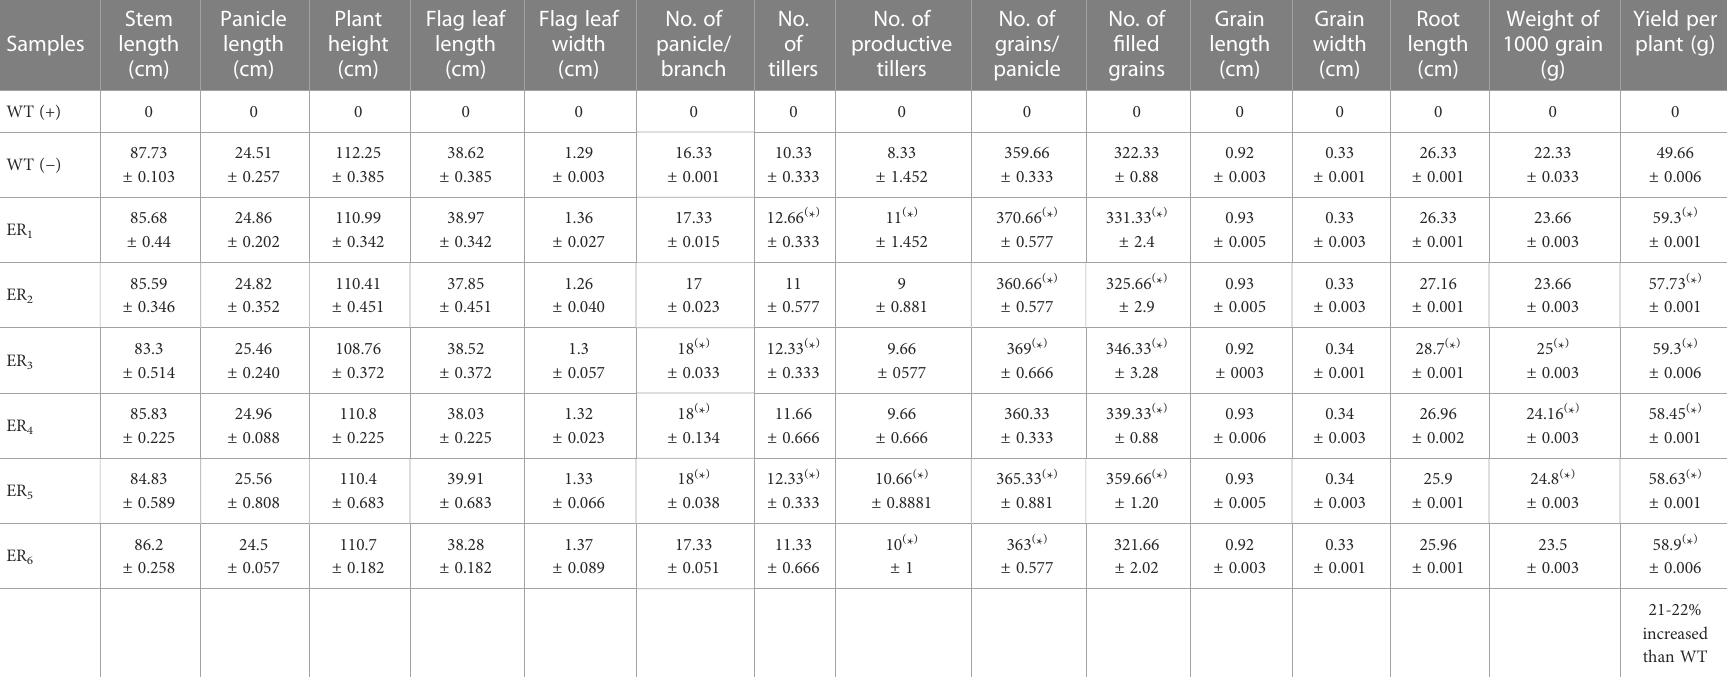
TABLE 1 (A) Agronomic traits performances analyses of WT and edited plants after glyphosate spraying under fi eld conditions.